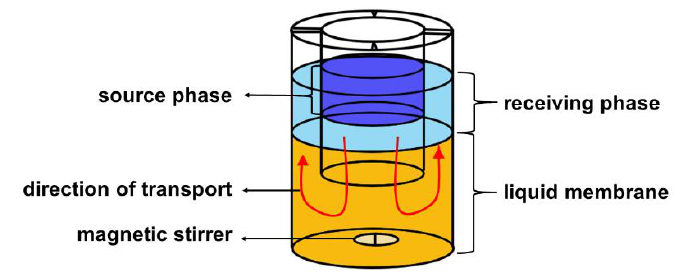
Figure 2. Bulk liquid membrane cell used for phase transport studies (active transfer surface: 7.07 × 10 −4 m 2